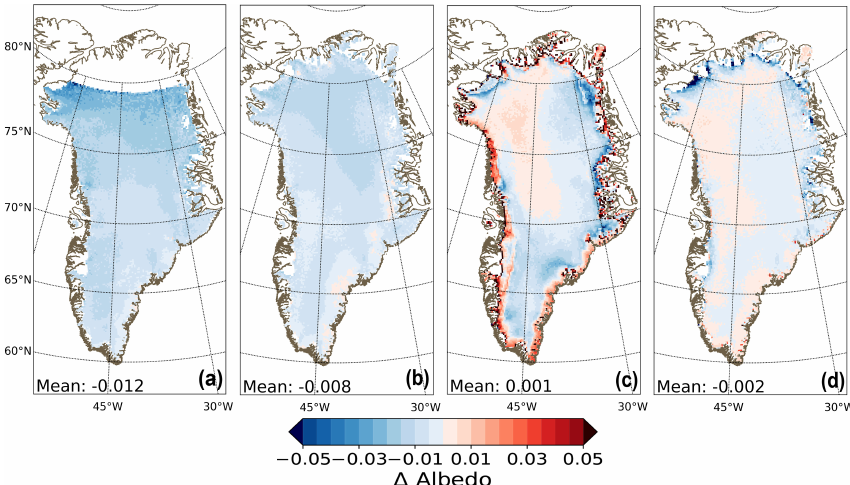
Figure 10. Average 16d running mean total-sky albedo difference between RACMO2.3p3 and RACMO2.3p2 for (a) DJF, (b) MAM, (c) JJA and (d) SON, for 15:00UTC between 2006 and 2015.